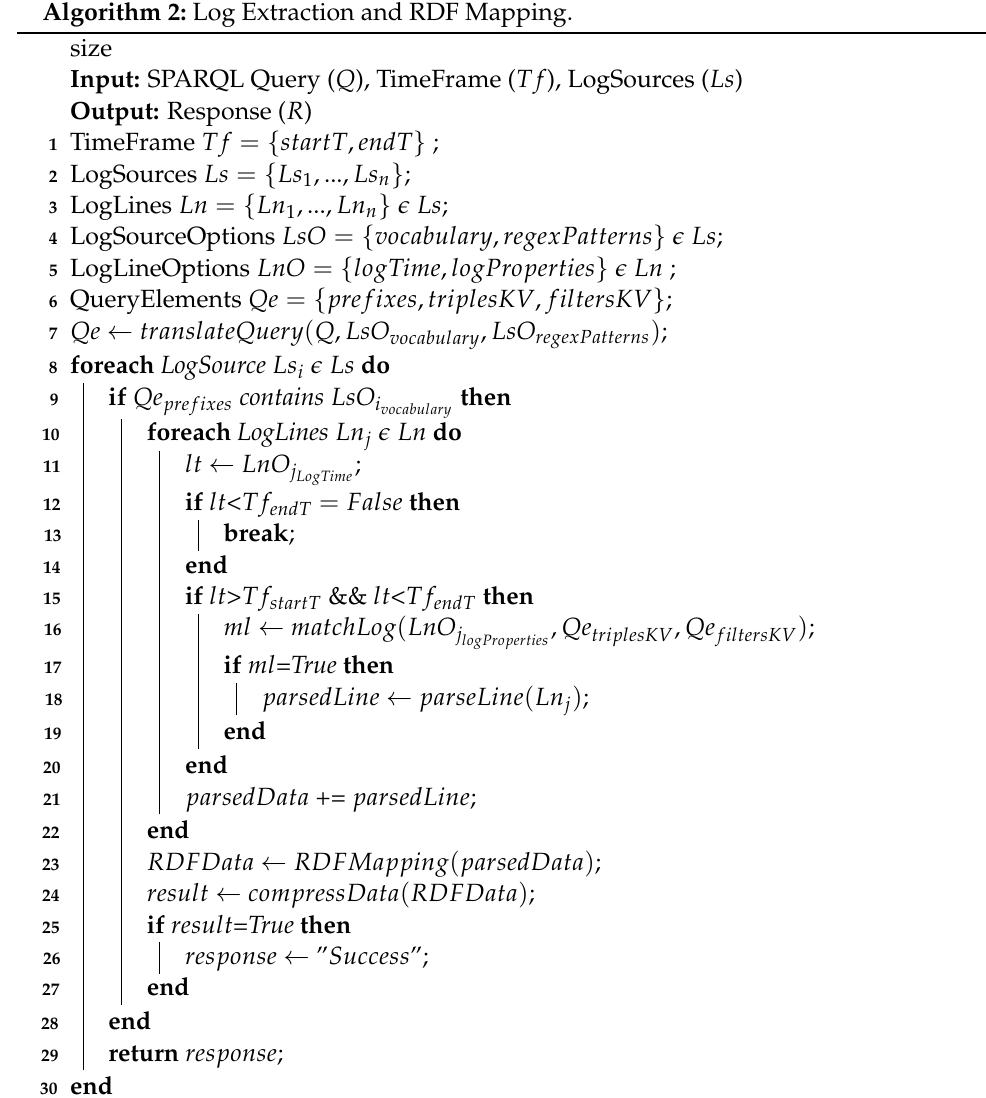
Algorithm 2: Log Extraction and RDF